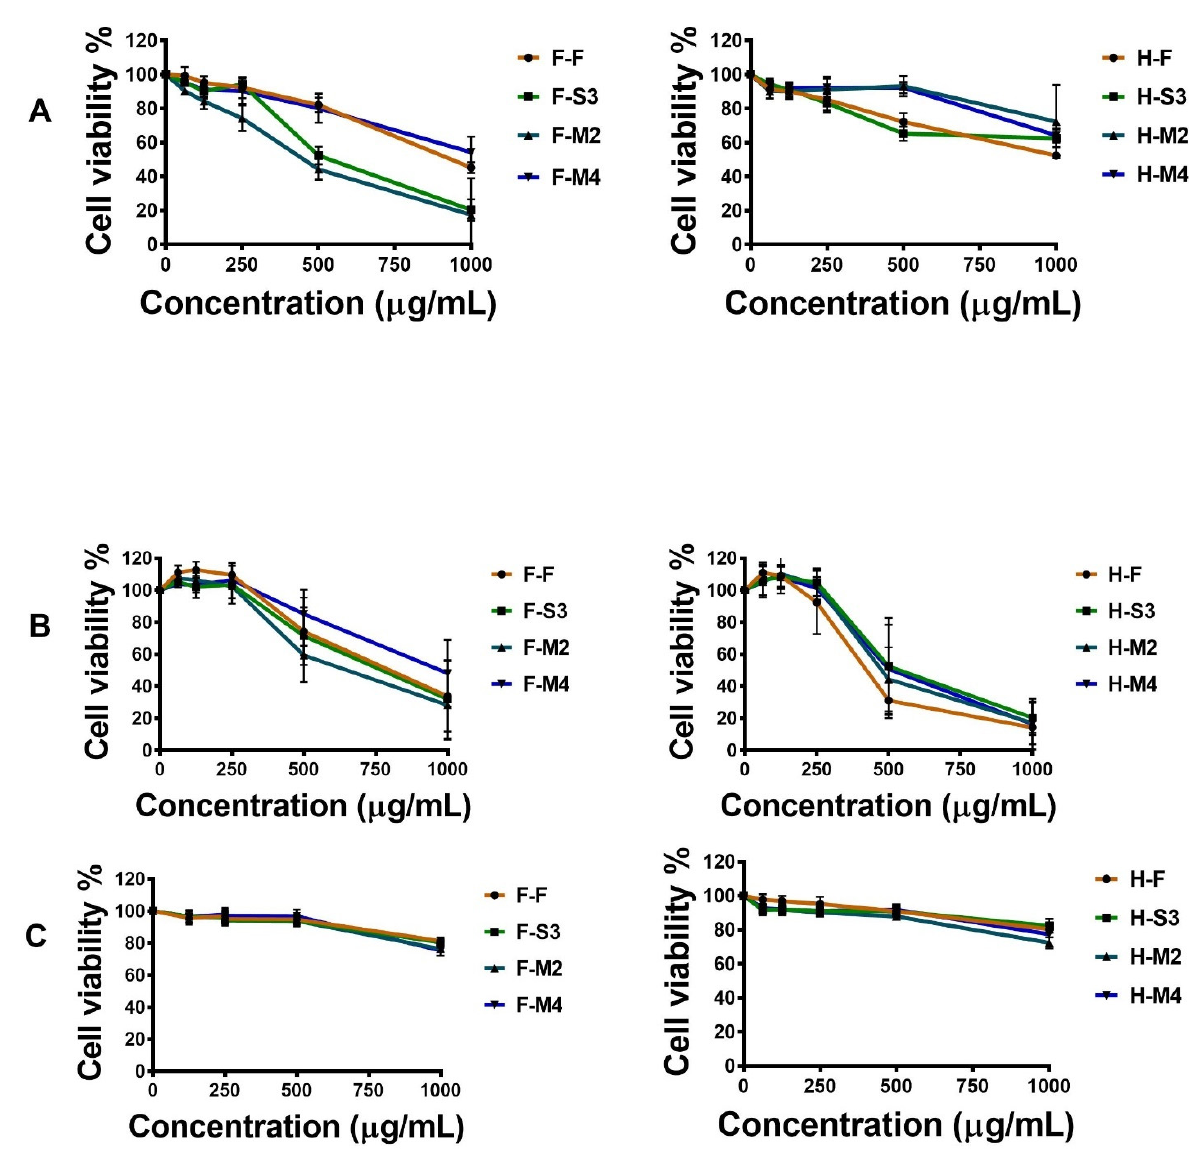
Figure 5. Cytotoxic effects of broccoli extracts (fresh-hot-air-dried (H-F), steamed (3 min)-hot-air-dried (H-S3), microwaved (2 min)-hot-air-dried (H-M2), microwaved (4 min)-hot-air-dried (H-M4), fresh-freeze-dried (F-F), steamed (3 min)-freeze-dried (F-S3), microwaved (2 min)-freeze-dried (F-M2), and microwaved (4 min)-freeze-dried (F-M4)) in MCF-7 ( A ), MDA-MB-231 ( B ), and MCF-10A ( C ) cells as assessed using the MTT assay. Table 2. IC 50 values ( µ g/mL) of broccoli extracts (F-F, F-S3, F-M2, F-M4, H-F, H-S3, H-M2, and H-M4) in MCF-7 and MDA-MB-231 cells following 48-h exposure as assessed using the MTT assay.